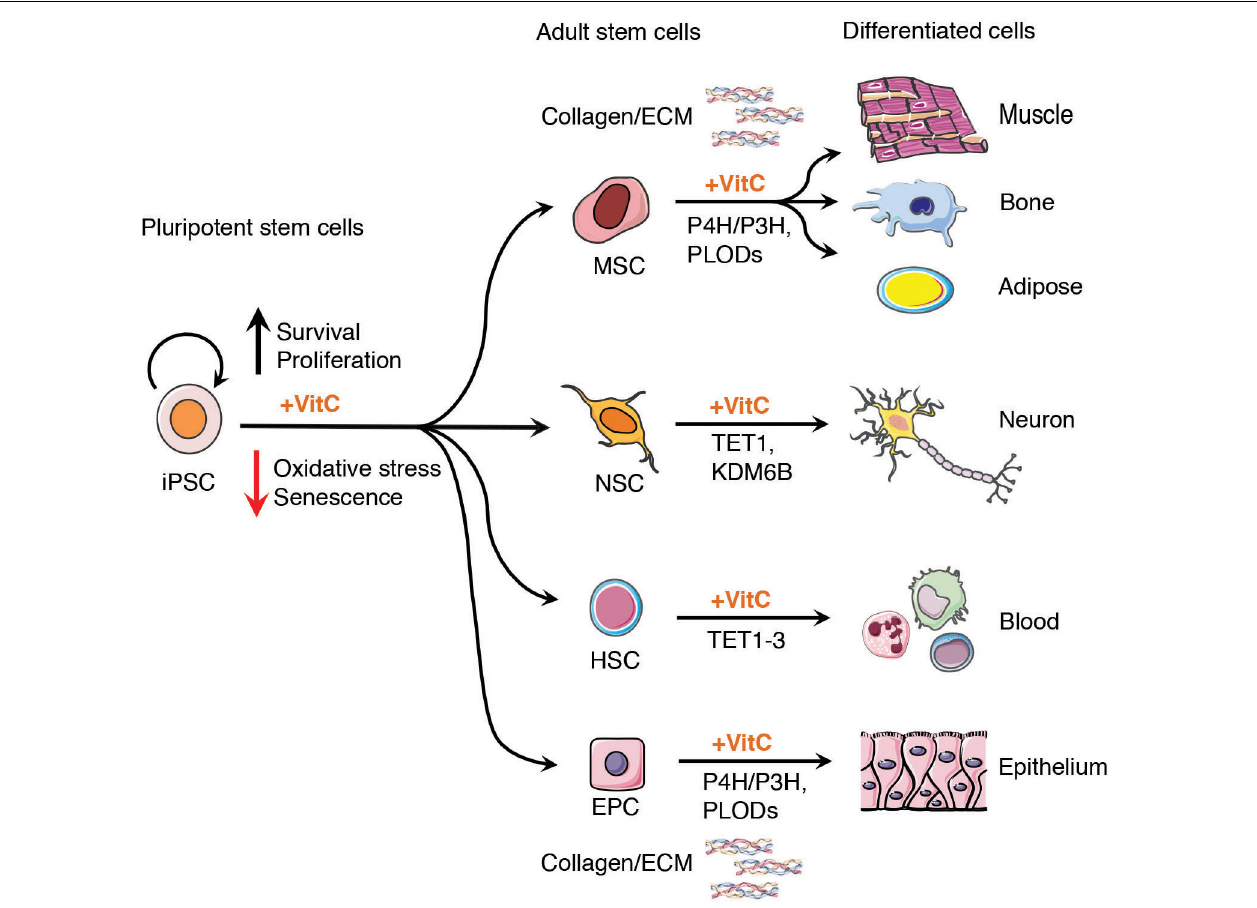
FIGURE 2 | Vitamin C enhances stem cell therapeutic potential. Vitamin C maintains the proliferation and self-renewal capacity of tissue specific stem and progenitor cells derived from iPSCs in culture, including epithelial stem and progenitor cells (EPC), neural stem cells (NSC), mesenchymal stem cells (MSCs), and hematopoietic stem cells (HSCs). The addition of vitamin C to the culture medium of cells enhances the activity of α -ketoglutarate dependent dioxygenases ( α -KGDDs) including Jumonji-C domain-containing histone demethylase (JHDM) such as KDM6B, ten-eleven translocation (TET1-3) proteins, prolyl Hydroxylases (P4H, P3H) and pro-collagen-lysine α -KG 5-dioxygenases (PLODs). Vitamin C may serve as a key adjuvant in preclinical models of iPSC-based regenerative medicine providing a renewable source of cells for tissue regeneration with potential to form epithelium, neurons, fat tissue (adipocytes) bone and heart muscle (cardiomyocytes), maintaining epigenetic plasticity to maximize progenitor cell differentiation capacity. The enhanced activity of collagen prolyl hydroxylases in the presence of vitamin C can also contribute to higher quality tissues for engraftment, highlighting an important non-epigenetic role of vitamin C in stem cell therapies.